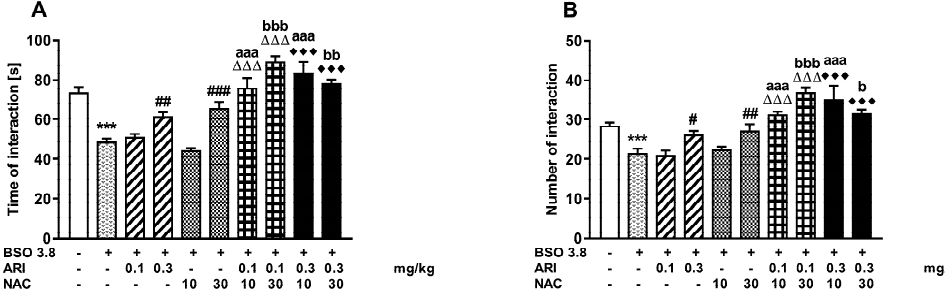
Figure 1. Effects of chronic treatment with aripiprazole (ARI) and N-acetylcysteine (NAC), alone or in combination, on social behavior deficits assessed as the total time spent in social interactions ( A ) and the number of interactions ( B ) in adult Sprague–Dawley rats that were induced by repeated BSO administration in the early postnatal days p5–p16. Data are presented as the mean ± SEM, n = 12 (6 pairs) for each group. Statistical analysis was performed using a one-way ANOVA for the planned comparisons; symbols and letters indicate significance of differences between the studied groups, *** p < 0.001 vs. control, vehicle-treated group; ### p < 0.001, ## p < 0.01, # p < 0.05 vs. BSO- (cid:7)(cid:7)(cid:7) p treated group; ∆∆∆ p < 0.001 vs. BSO + ARI (0.1 mg/kg)-treated group; < 0.001 vs. BSO +